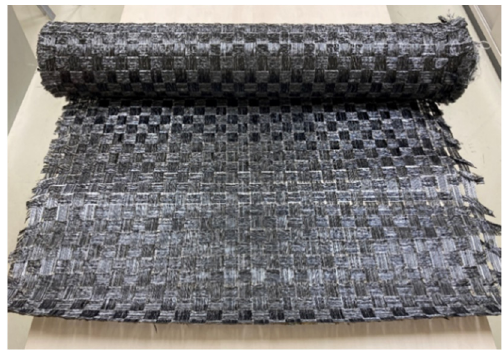
Figure 2. Woven fabric using spread commingled yarn.